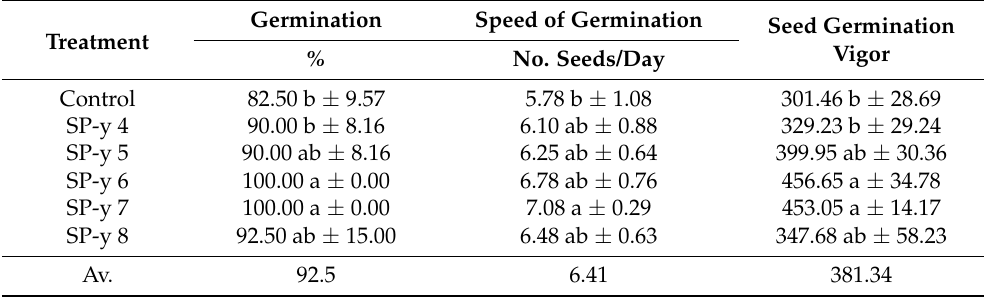
Table 2. Mean comparison of effects of different concentrations of S. yanoikuyae SJTF8 on rice seed germination percentage, speed of germination, and germination vigor.